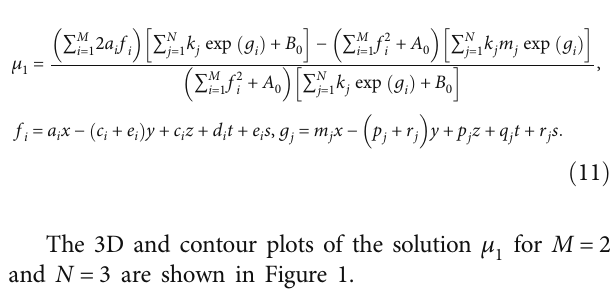
= c = d = e = 1, m 2 2 2 2